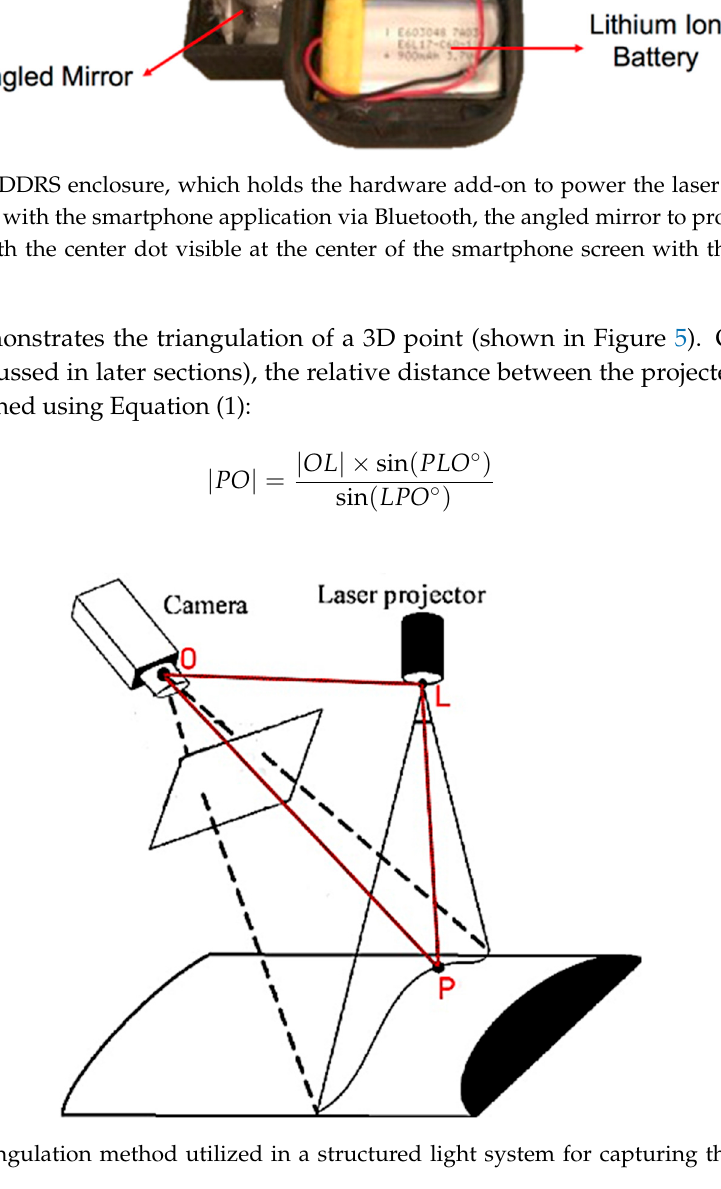
Figure 6. DDRS enclosure with the 2-dimensional angled mirror housing highlighted with a red circle. The laser module used to create the structured laser system is a 5 mW, 532 nm diode purchased from Laser Components [25]. Choosing a 532 nm laser diode allows better visibility for the user when operating the DDRS. Additionally, using a 5 mW instead of 1 mW module ensures enough power for the laser beam to pass through the diffraction lens and project onto the food items. A more detailed specification of the laser module is presented in Table 2. Table 2. FLEXPOINT 532 nm green laser module specifications. Specifications Measurement